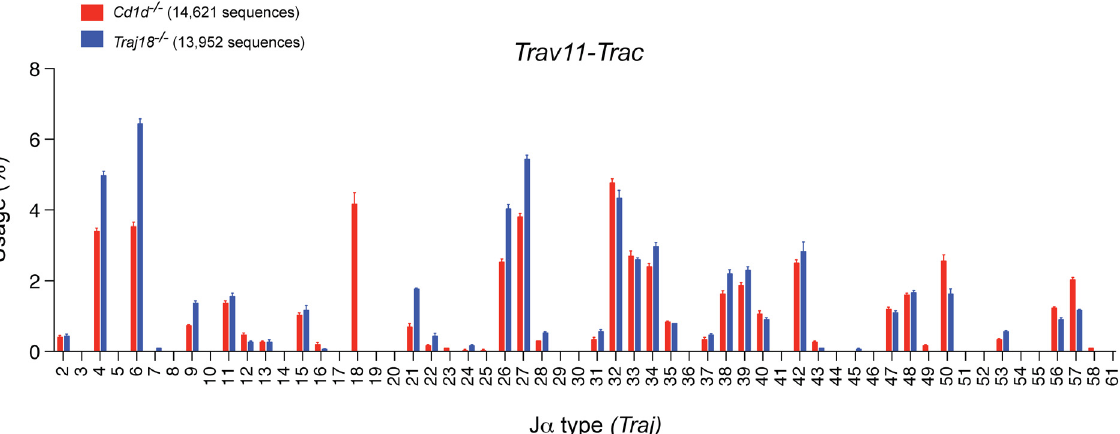
Fig 3. Undisturbed TCR α chain joining region usage in newly generated Traj18 -deficient mice as revealed by next generation sequencing. Sequencing of TCR α chain joining region. PCR was carried out to amplify Trav11-Trac transcripts using cDNA prepared from sorted TCR β low CD4 + CD8 + double-positive thymocytes from Cd1d1 -/- Cd1d2 -/- (red bars) and Traj18 -/- (blue bars) mice. Bars depict mean ± SEM percentages of productive Traj gene segment rearrangements, and data are derived from three biologically independent samples per genotype. Numbers in parenthesis indicate the total number of sequences analyzed. The data are from one experiment.